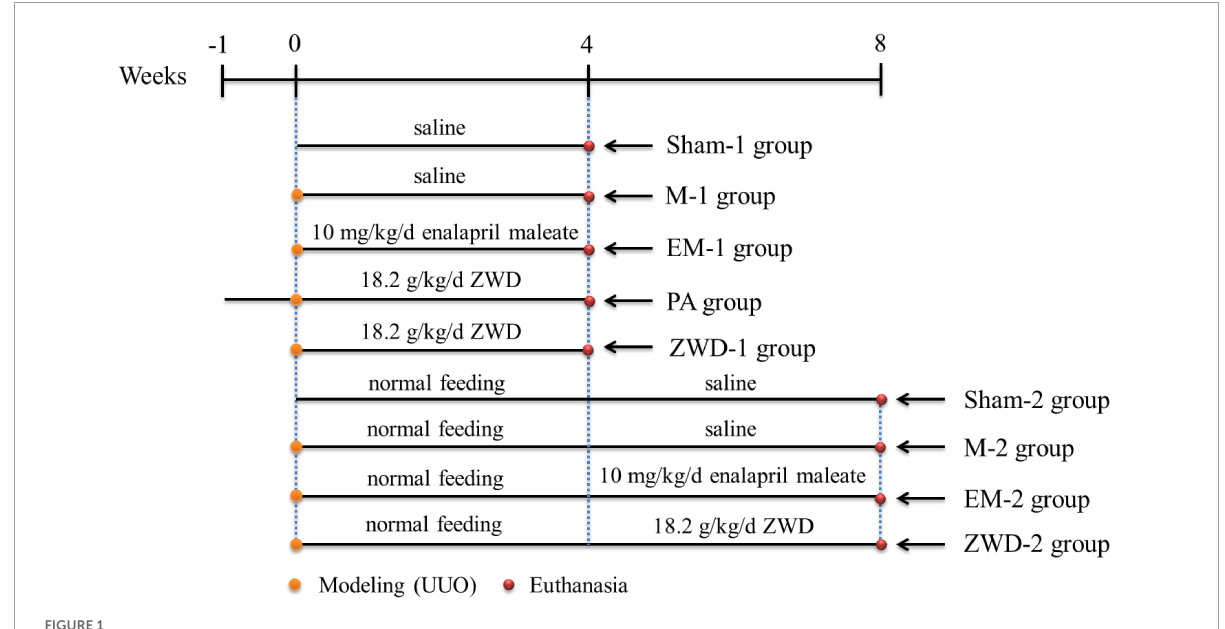
FIGURE1 Schematic of the animal experiment and sampling